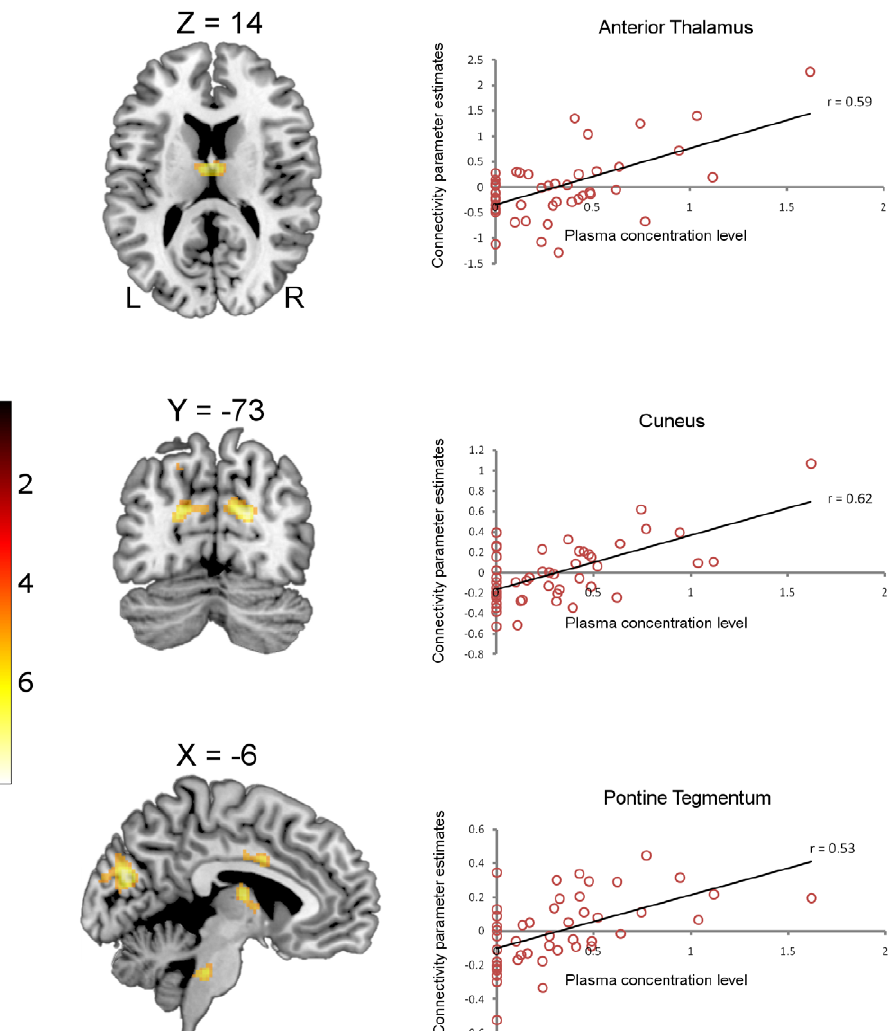
Figure 3. Increasing connectivity between the PCC and the thalamus (top panel), cuneus (middle panel) and the pontine tegmentum (bottom panel) in response to increasing propofol plasma concentrations (awake is modeled as zero). Correlations significant at p # 0.001: anterior thalamus r=0.59, cuneus r=0.62, pontine tegmentum r=0.53. Talairach and Tournoux coordinates are shown above each T1 weighted brain slice. The color bar indicates strength of connectivity (t score).